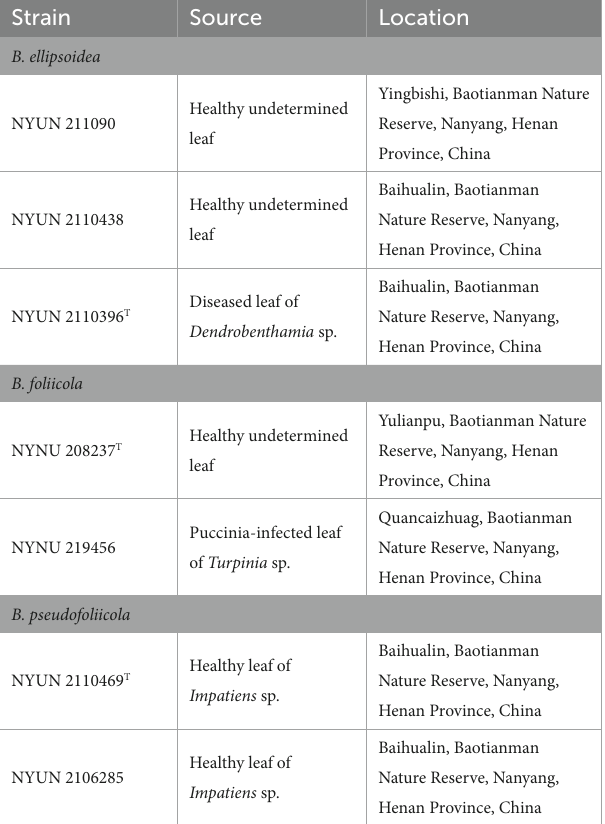
TABLE 1 Novel yeast strains isolated from plant leaves.